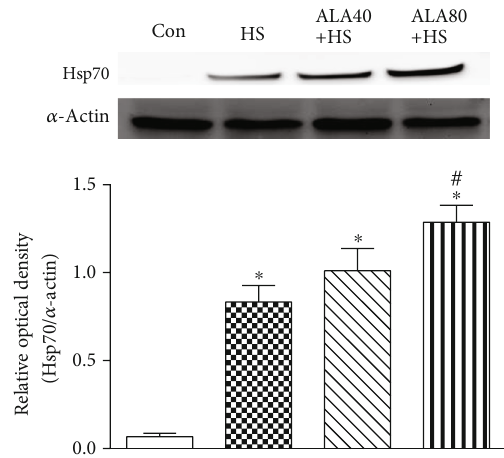
Figure 6: E ff ects of pretreatment with α -lipoic acid (ALA) on Hsp70 protein expression in the myocardium of heat stroke rats. Data are expressed as mean ± SEM ( n = 5 -8). ∗ P < 0 : 05 versus Con; # P < 0 : 05 versus